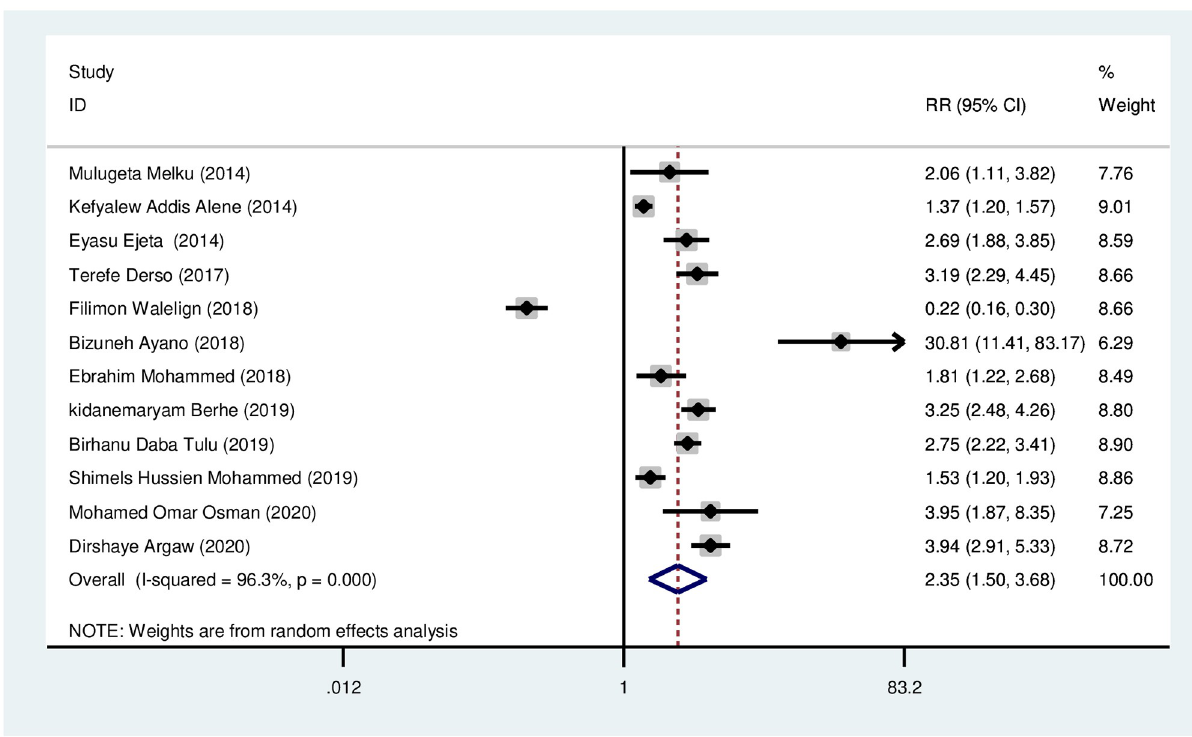
Fig 5. Association of mid-upper arm circumference with anemia during pregnancy.